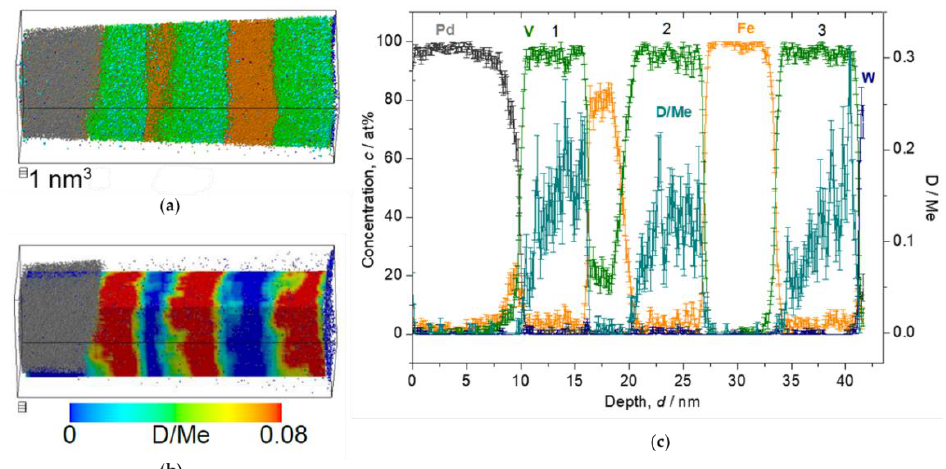
Figure 9. Reconstructed volume of Fe/V multi-layer (15 nm × 15 nm × 42 nm), loaded with D 2 0.5 Pa, analyzed at 30 K. ( a ) The whole volume of reconstruction (grey: Pd, green: V, orange: Fe, blue: W, light blue: D). ( b ) Iso-concentration map of D concentration ( c D = 0.08 D/Me) from the same reconstruction in ( a ). ( c ) Depth concentration profile from 5 nm φ cylinder volume.